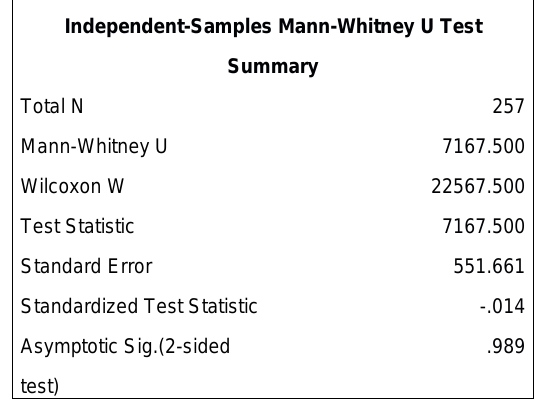
Table 1 Results of the Mann-Whitney-U